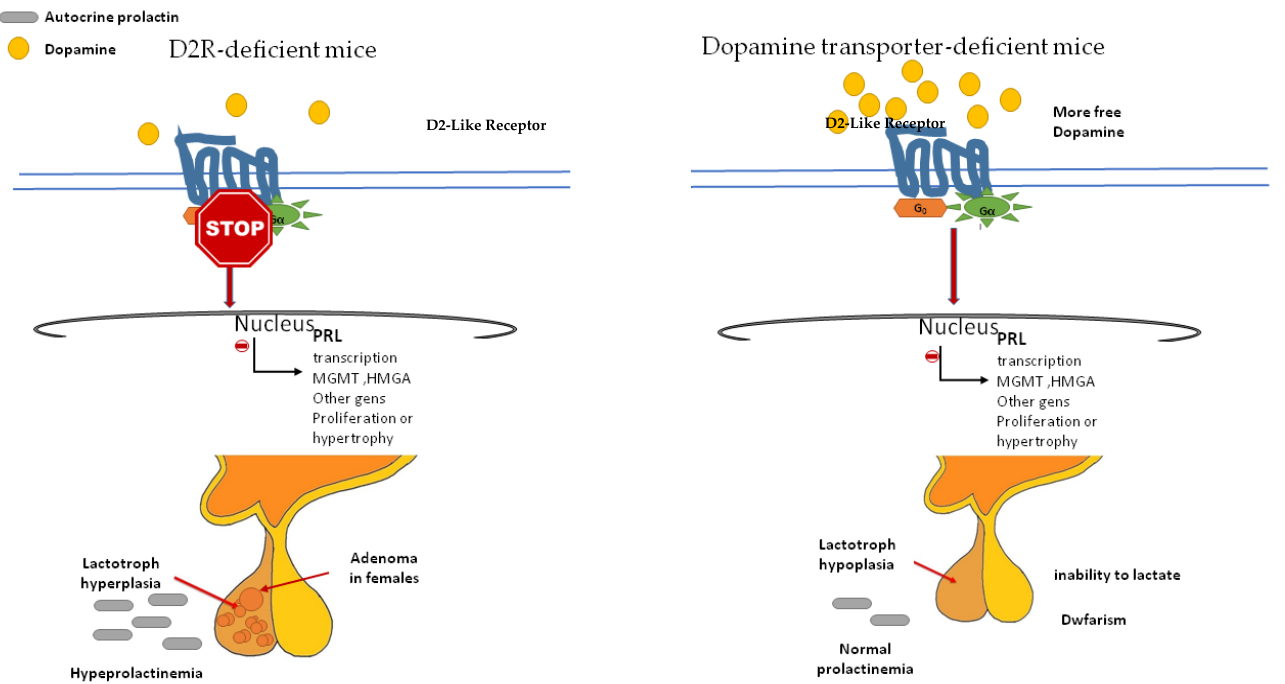
Figure 4. Dopamine receptor-deficient mice and dopamine transporter-deficient mice. D2R-deficient mice, led to hyperprolactinemia, lactotroph hyperplasia in male and adenomas in female. Dopamine transporter-deficient mice have an increased dopaminergic tone due to dopamine availability. D2R: dopamine receptor.